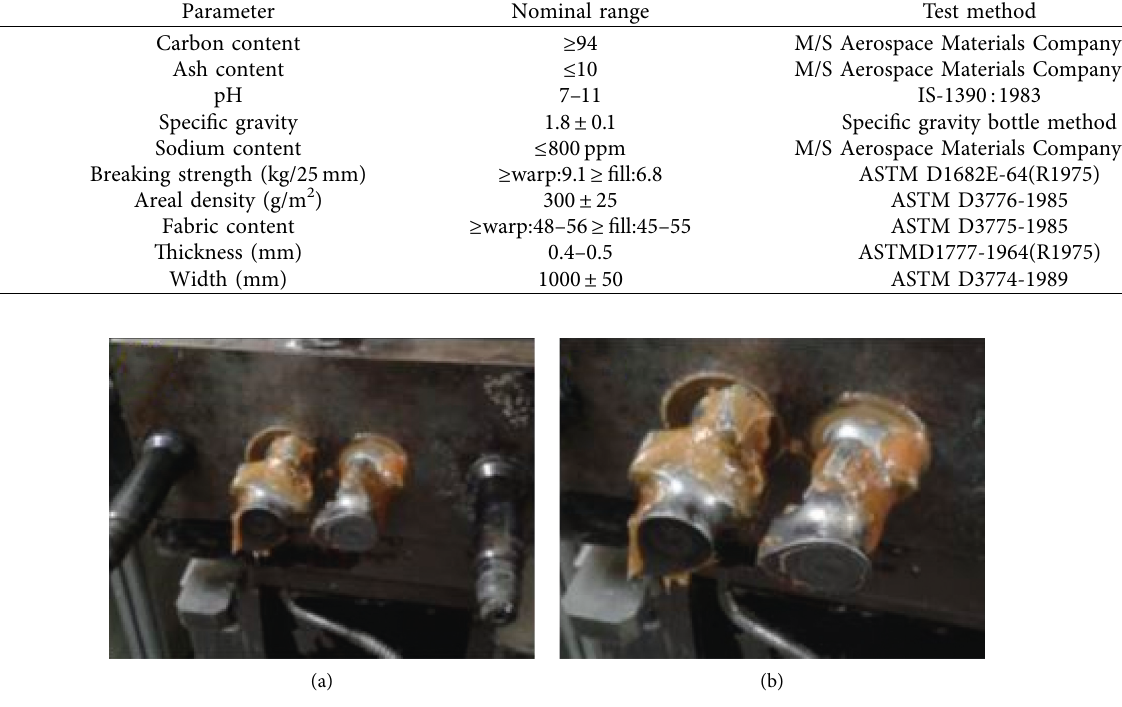
Figure 2: Mixing of nanofumed silica with phenolic resin using Haake